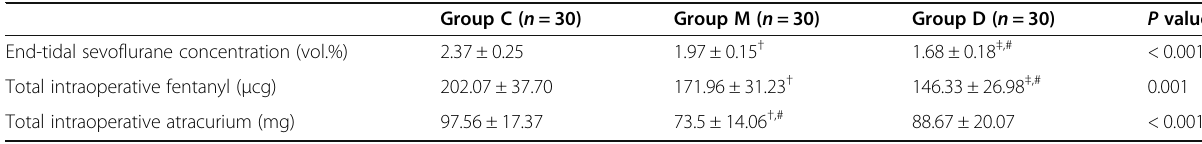
Table 5 Intraoperative anesthetic agent requirements expressed as mean ± SD End-tidal sevoflurane concentration